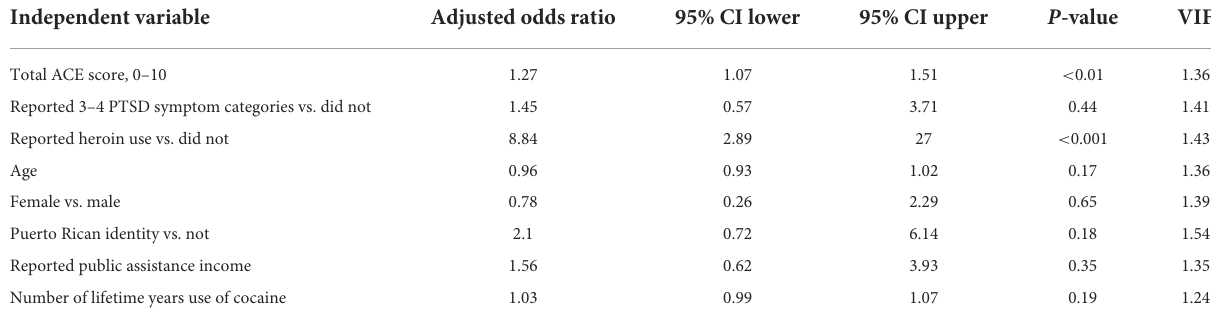
TABLE 3 Multiple logistic regression model on lifetime overdose, n =